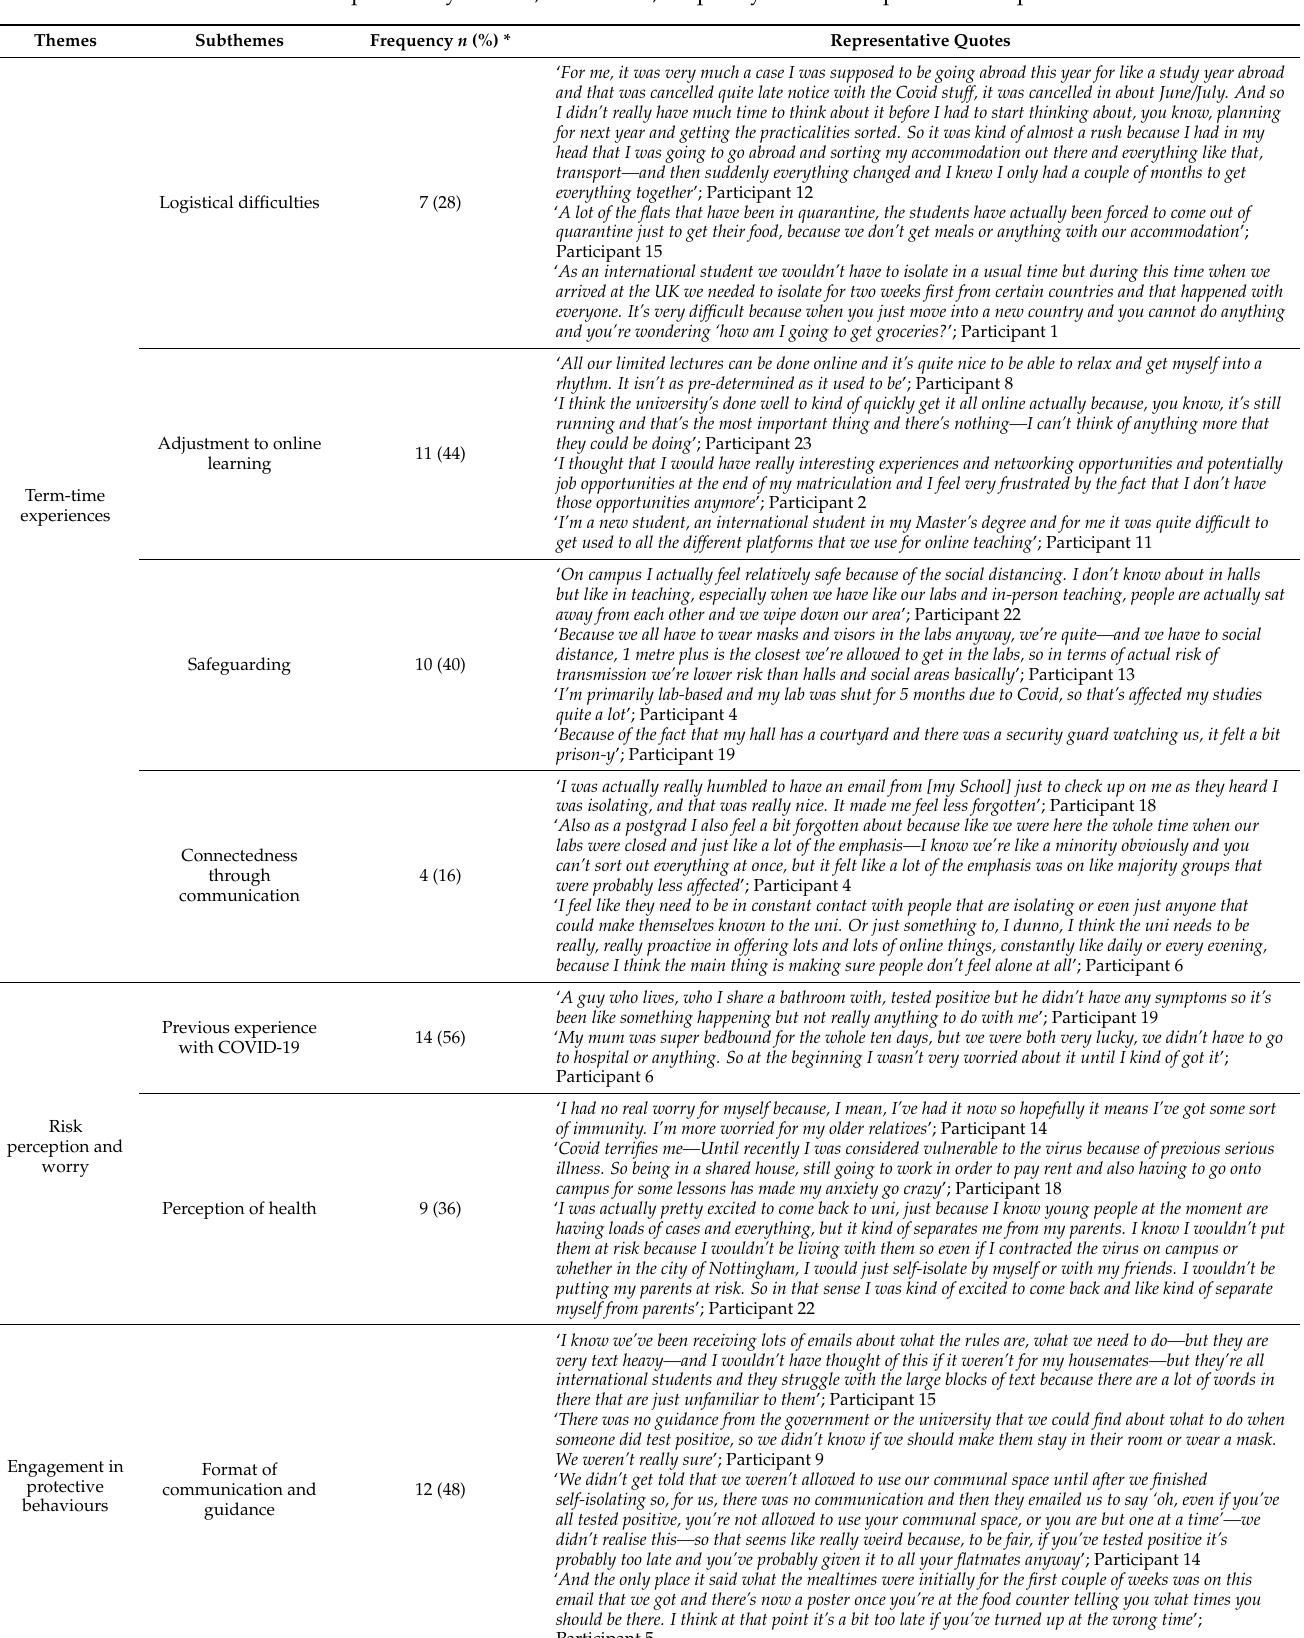
Table 2. Examples of key themes, subthemes, frequency and their representative